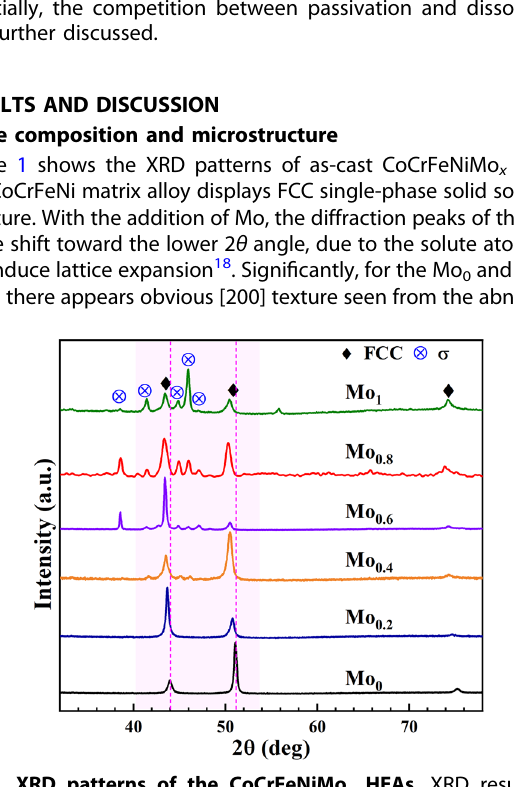
Fig. 1 XRD patterns of the CoCrFeNiMo x HEAs. XRD results of CoCrFeNiMo